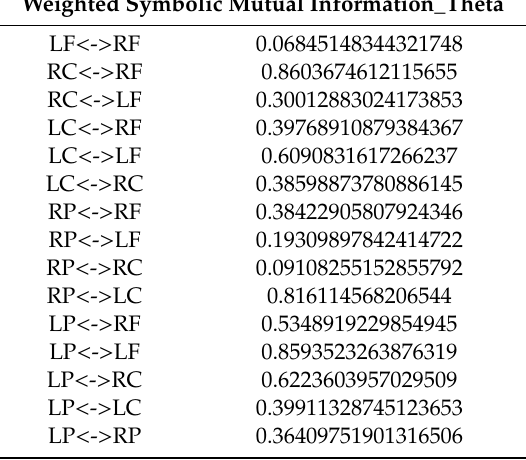
Table A1. p -Values Obtained for the Weighted Symbolic Mutual Information Connectivity Analysis in the Theta Band.